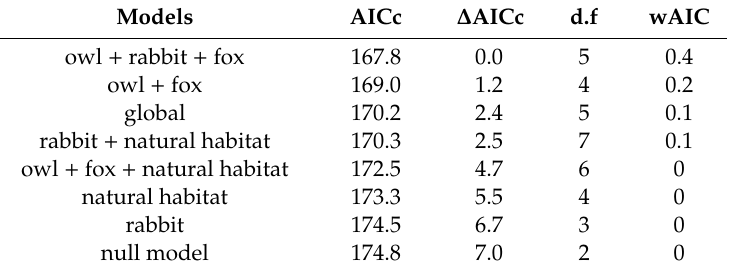
Table 2. Model selection rank on the distribution and habitat use of the stone marten considering the number of eagle owl pairs as the marten’s predator, red fox as predator or competitor, the abundance of the rabbit as the staple prey of owls and a marten prey, and natural habitat (referred cover of forest and shrublands). Models AICc ∆ AICc d.f wAIC owl + rabbit + fox 167.8 0.0 owl + fox 169.0 global 170.2 owl + fox + natural habitat 172.5 natural habitat 173.3 rabbit 174.5 174.8